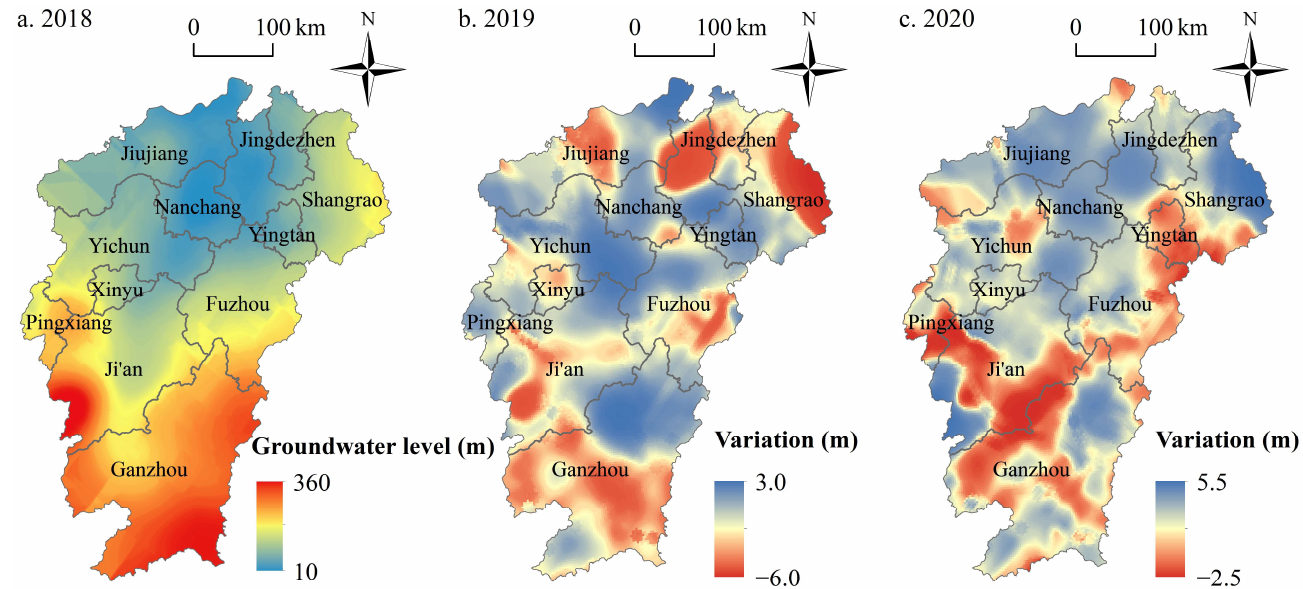
Figure 3. Spatial distribution of the groundwater level variation in the PLB. ( a ) Spatial distribution of groundwater level in the PLB in 2018; ( b ) Spatial distribution of groundwater level variation in PLB in 2019 relative to 2018; ( c ) Spatial distribution of groundwater level variation in PLB in 2020 relative to 2019.